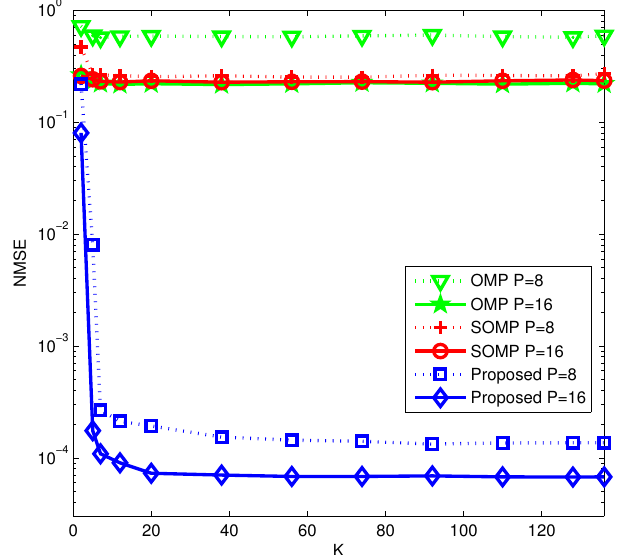
Figure 4. NMSE comparison among different algorithms versus the number of subcarriers K